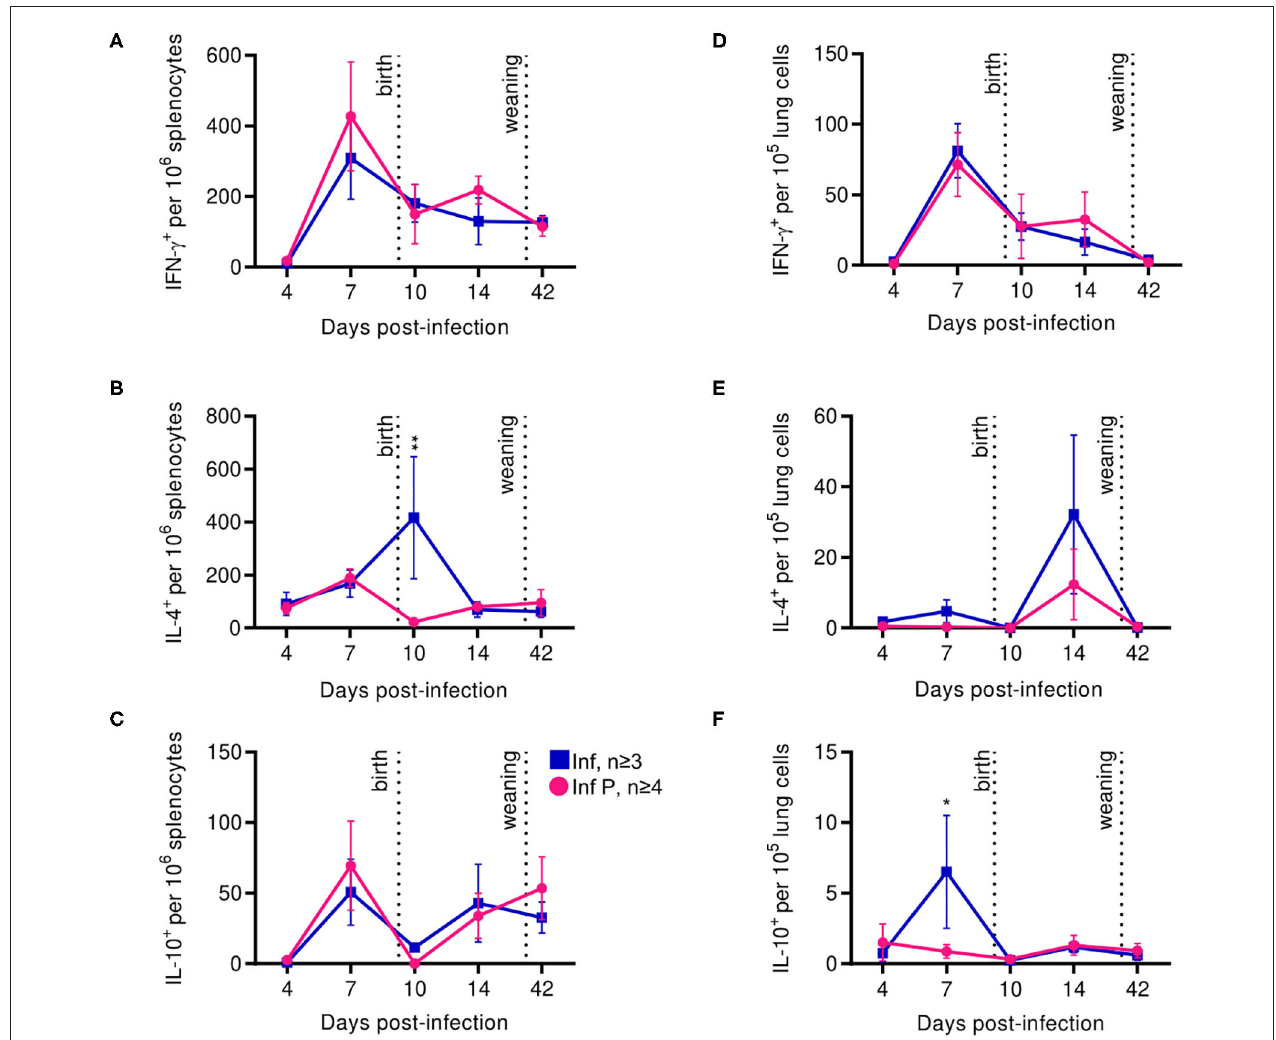
FIGURE 8 | Proinflammatory T cell secretion profiles among pregnant mice are indistinguishable from non-pregnant animals, while anti-inflammatory secretions increase in the spleen after delivery. ASCs were quantified for IFN- γ (A) , IL-4 (B) , and IL-10 (C) secretion among splenocytes by ELISpot assay at 4, 7, 10, 14, and 42 DPI. IFN- γ (D) , IL-4 (E) , and IL-10 (F) secretion were also quantified in lung cells for the same days. All data was analyzed via Two-way ANOVA using Sidak correction for multiple comparisons. Error bars represent Standard Error of Mean (SEM) for all graphs. * p < 0.05; ** p <